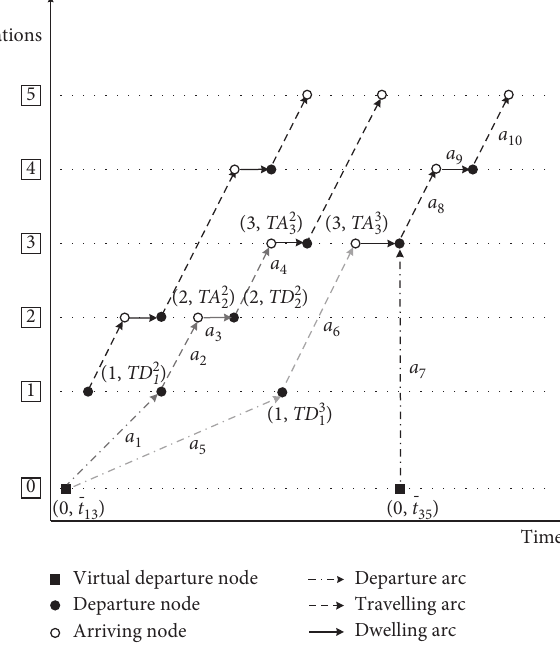
Figure 4: Traveling time-space network for Figure